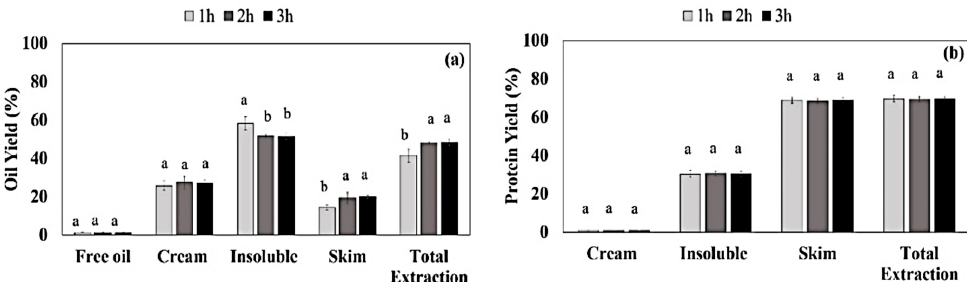
Figure 2. Experimental validation of the AEP conditions (1:12.82 SLR at 1, 2, and 3 h): ( a ) oil and ( b ) protein extraction yields for the AEP of almond cake. Means within the same fraction with different letters are statistically different at p < 0.05.